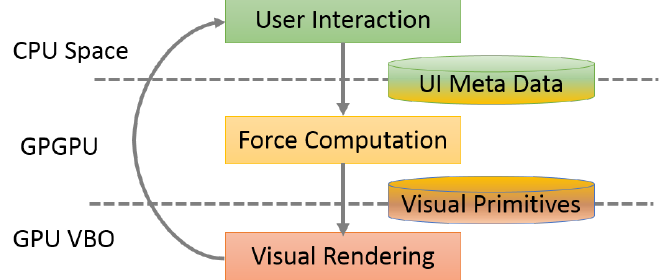
Figure 12. The flow chart of the iteration cycle of our large graph layout system. User interactions are inserted into iterative graph layout algorithm. During each iteration of the force directed layout algorithm, user interaction data are passed to the GPU to compute forces, and then visual primitives are updated based on the force calculations. To support interactivity, these iterations must be as light-weight as